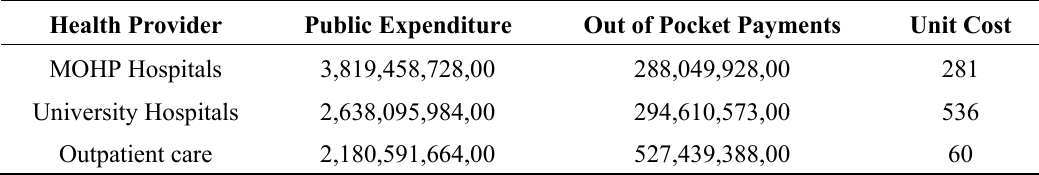
Table 1. Public health spending, in Egyptian Pounds, for the year 2008. Health